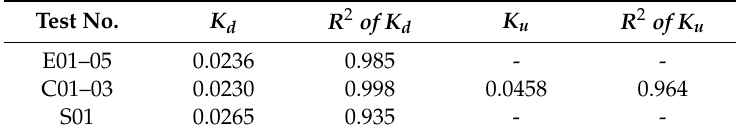
Table 4. Fitting results of all full-scale